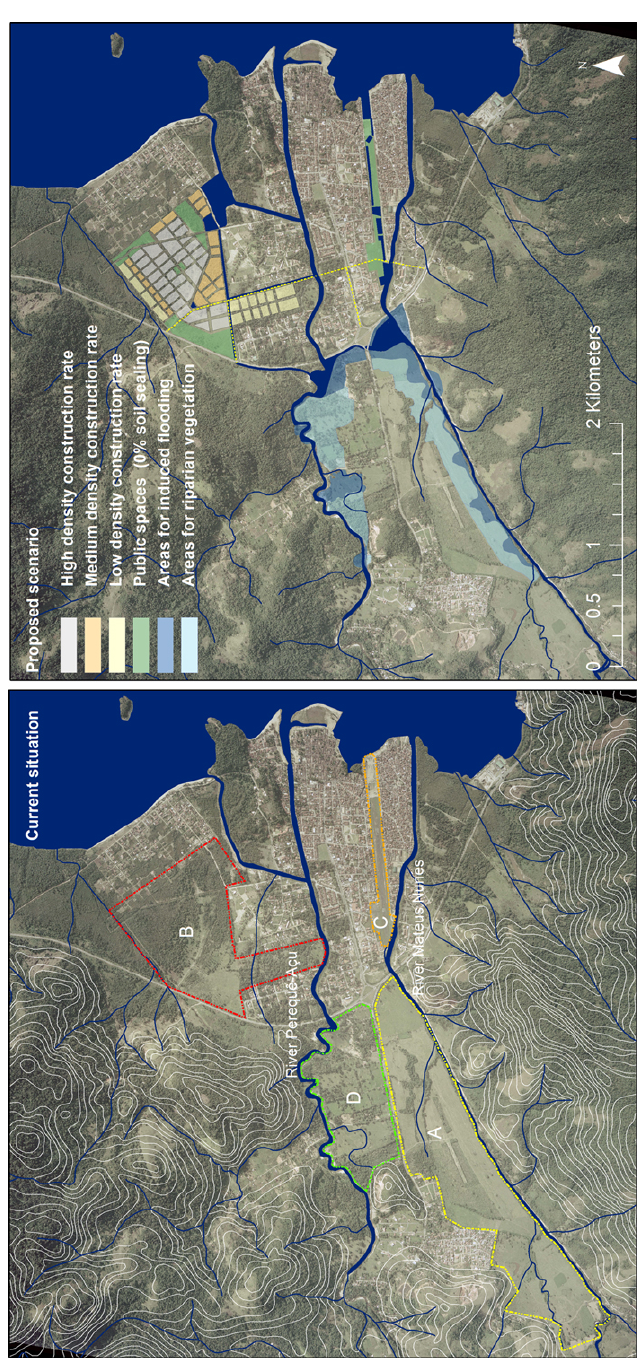
Fig. 2 . Current situation (description of main open spaces) and proposed scenario (river restoration and compact city). Click on image to